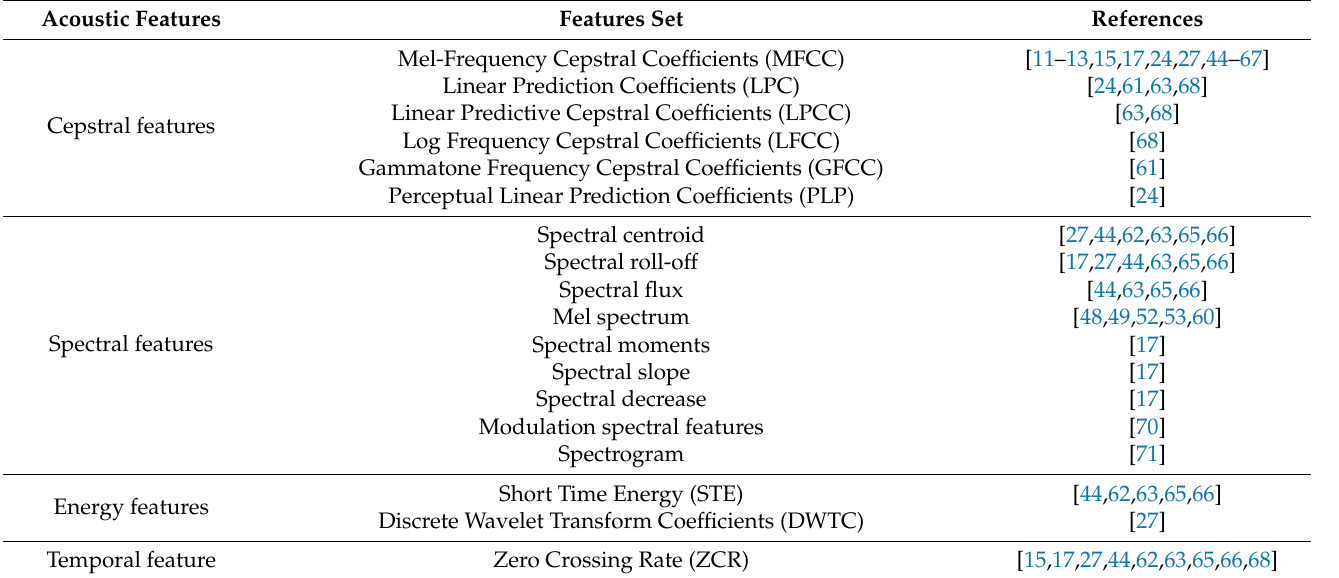
Table 4. Summary of acoustic features used in sound